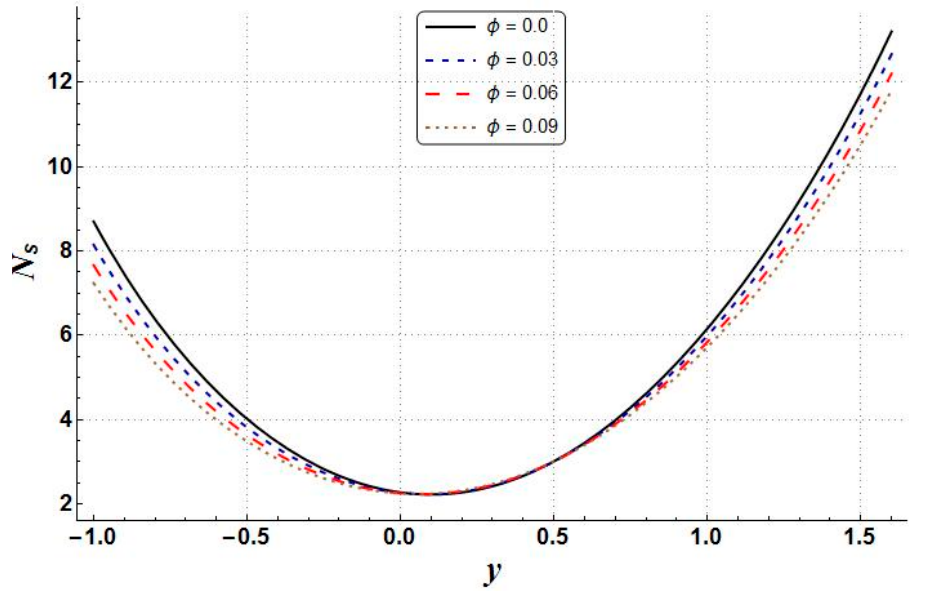
Figure 23. Influence on N S through changing values of φ , where γ = π M = 1, k = 2, a = 0.6, m = 1, d = 0.7, Br = 0.2, b = 0.5, ∈ = 2, η = 0.8.